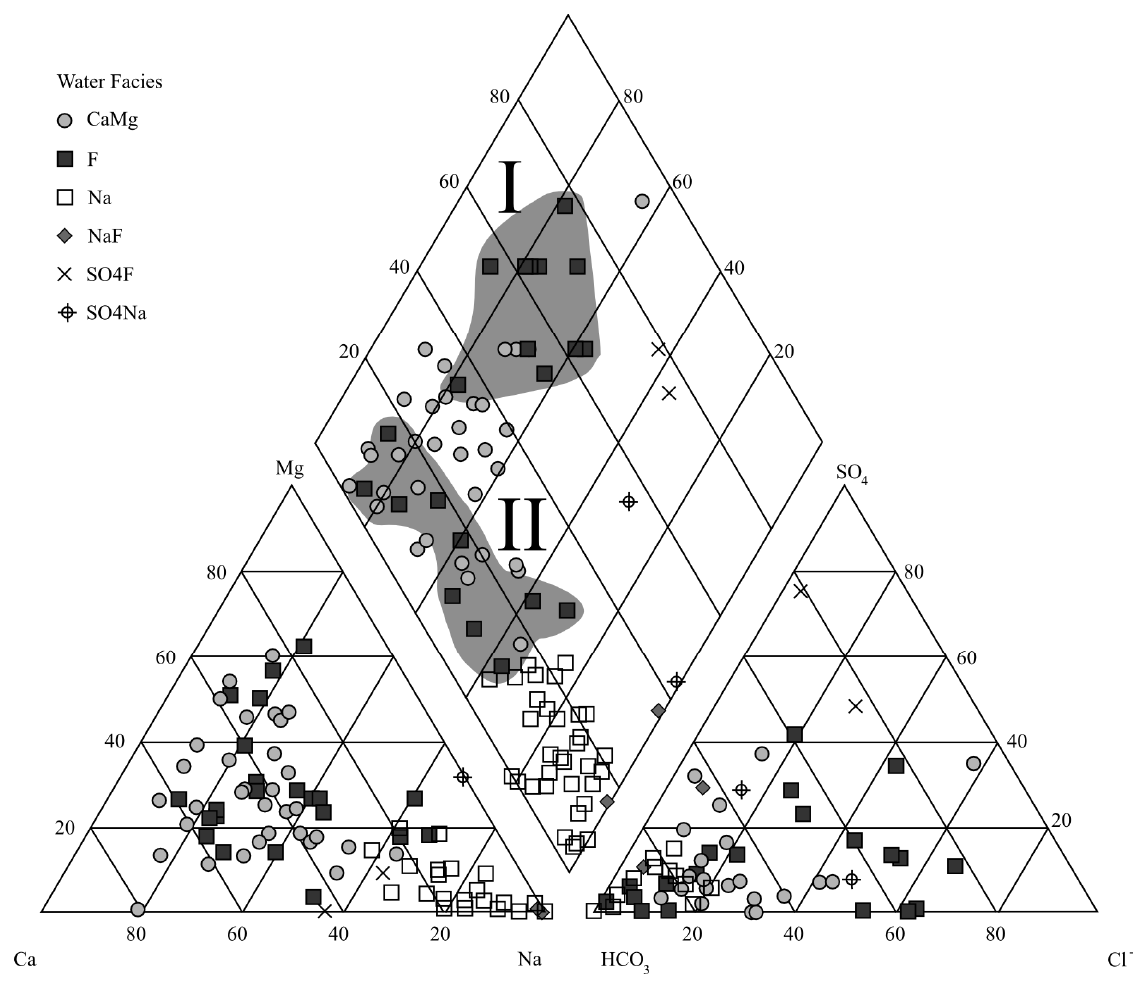
Fig. 2 – Water facies distribution in the Piper Diagram, showing two fluoride hydrochemical types (I – sulfated; II –